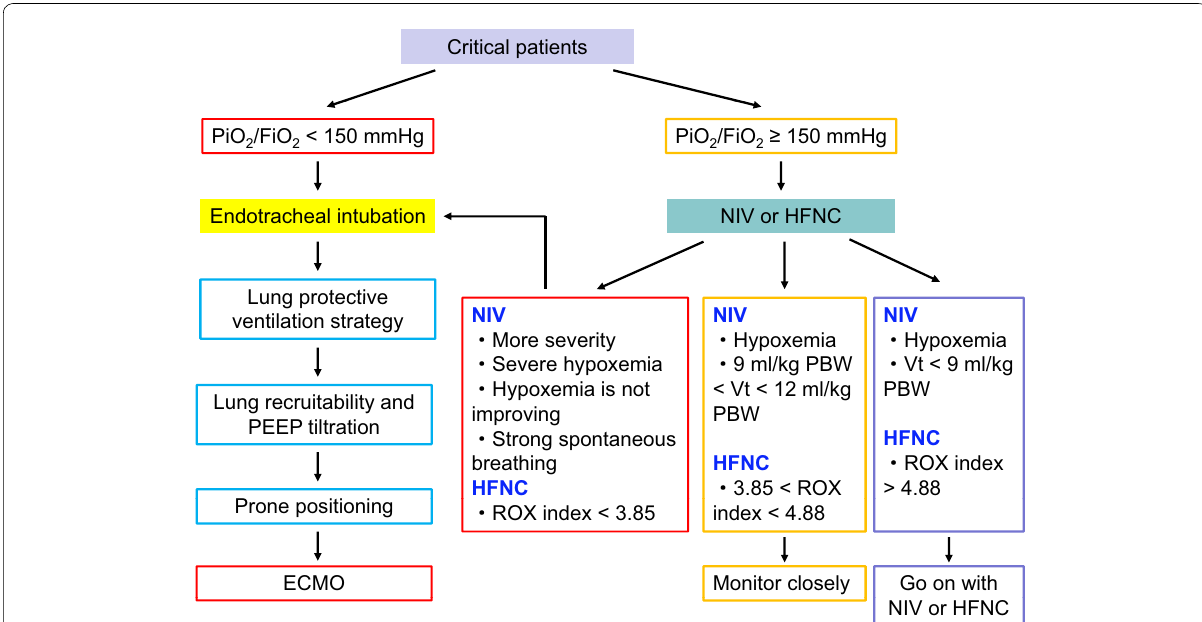
Fig. 1 Protocol of respiratory therapy for COVID-19-induced ARDS. NIV non-invasive ventilation, HFNC high-flow nasal cannula, PBW predict body weight, ECMO extracorporeal membrane